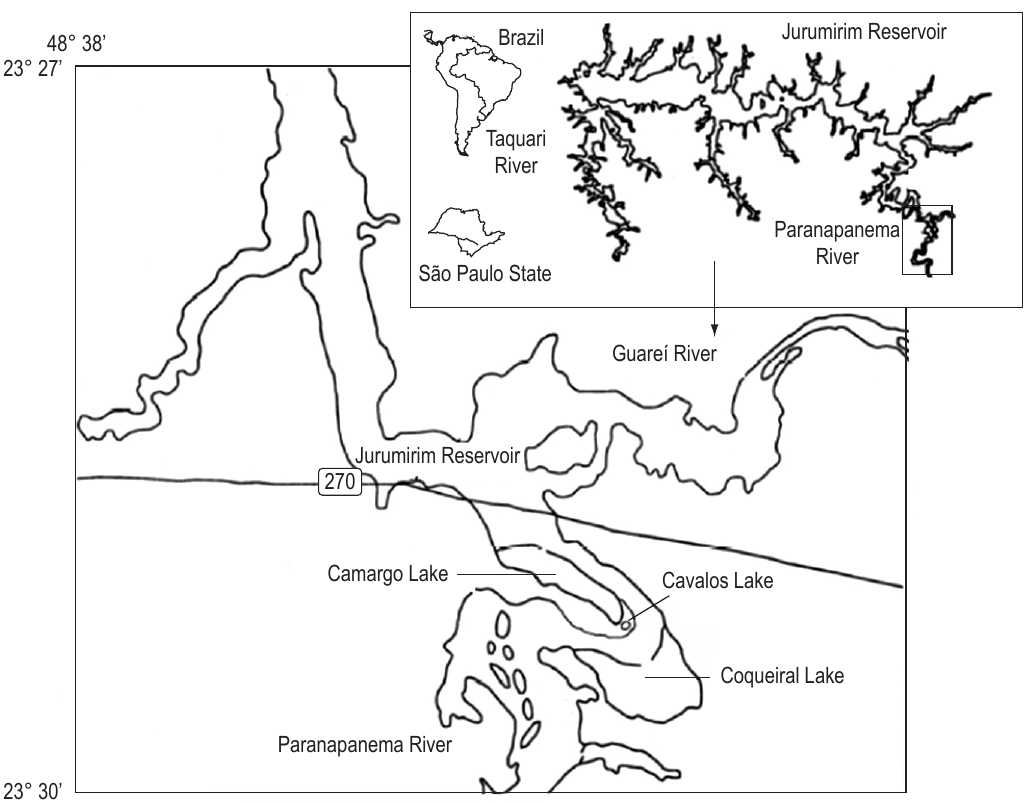
Figure 1. Study area and sampling